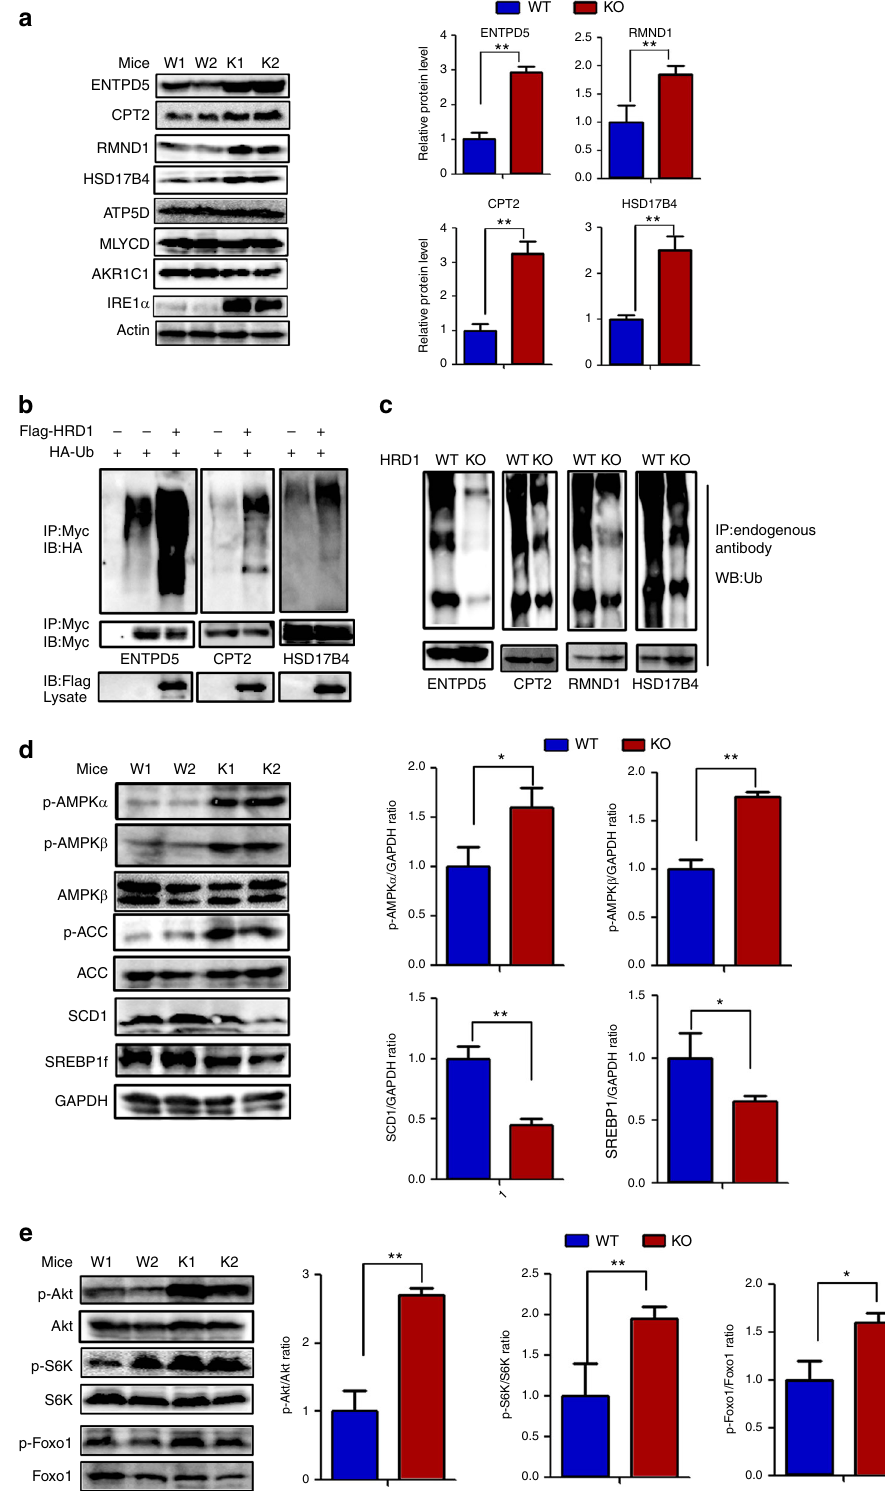
Fig. 4 HRD1 is an E3 ubiquitin ligase for liver metabolic regulators. a HRD1-binding protein levels in the liver of WT and HRD1 Alb mice under the refed condition. b Ubiquitination of HRD1 substrates after co-transfection with HRD1 in 293T cells. c Ubiquitination of HRD1 substrates in the liver of WT and HRD1 Alb mice under the refed condition. d Immunoblots of hepatic AMPK and AMPK targets in the WT and HRD1 Alb mice under the refed condition. e Immunoblots of hepatic p-Akt, Akt, p-S6K, S6K, p-Foxo1, and Foxo1 levels in the WT and HRD1 Alb mice under the refed condition. Data are representative of three independent experiments (mean ± s.d.). * P < 0.05. ** P < 0.01 by unpaired Student ’ s t